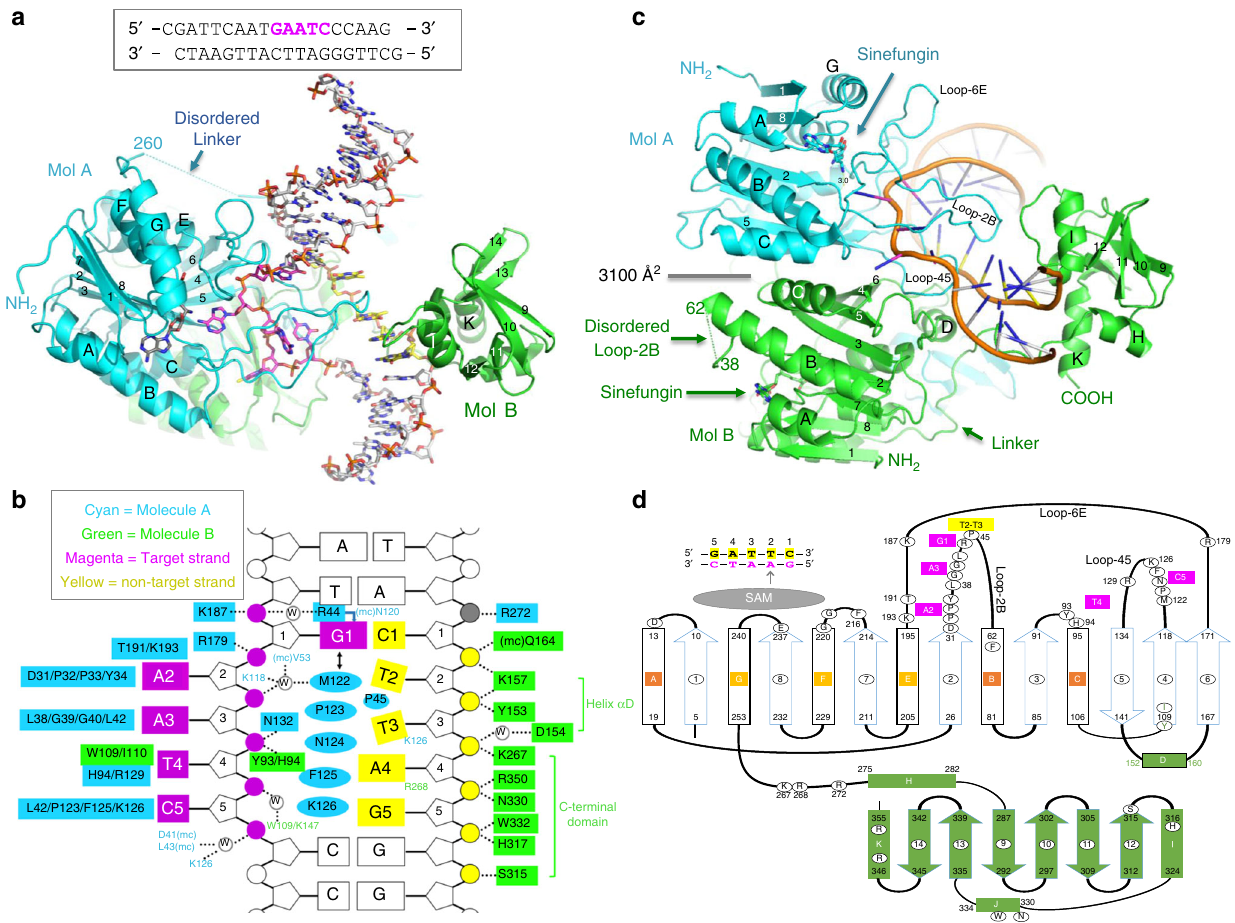
Fig. 1 Structure of CcrM-DNA complex. a The MTase domain of molecule A (in cyan) and the C-terminal domain of molecule B (in green) collaborate for the DNA binding. b Schematic of CcrM-DNA interactions: mc, main-chain-atom-mediated contacts: w, water-mediated hydrogen bonds. DNA bases in magenta represent the target strand, while non-target strand DNA bases are in yellow. Molecule A residues are in cyan, molecule B residues in green. c CcrM forms a dimer (Mol A in cyan and Mol B in green). The labels of secondary structural elements are according to panel d . d Schematic diagram of CcrM secondary structures, with N-terminal MTase domain (cyan lines for strands and black lines for helices) and C-terminal DNA binding domain (green). Helices are labeled from A to H and strands are labeled as 1 to